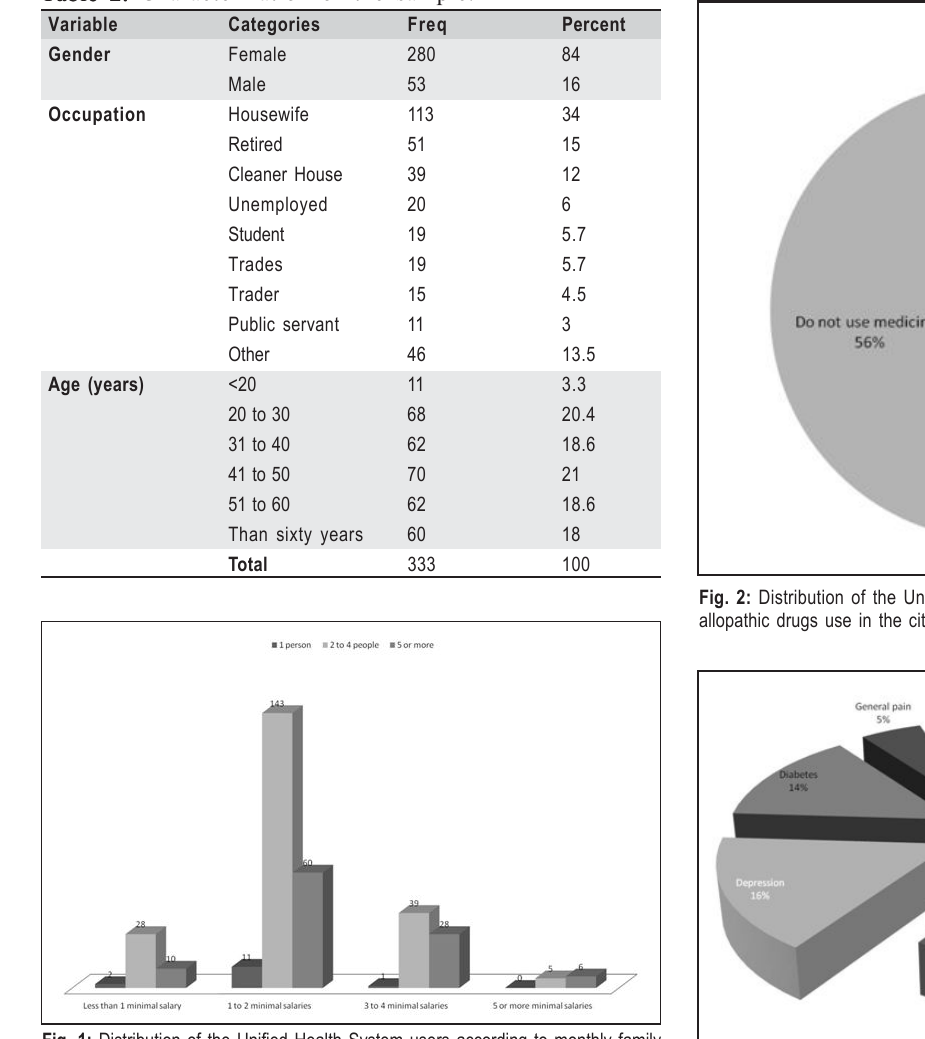
Fig. 1: Distribution of the Unified Health System users according to monthly family income in the city of Pelotas-RS, Brazil.